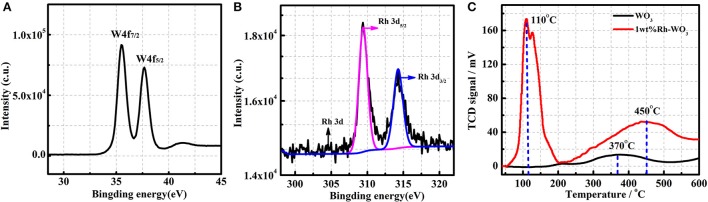
The XPS of 1wt%Rh-WO3: (A) W4f, (B) Rh3d, and (C) the H2-TPR patterns of pure WO3 and 1wt%Rh-WO3.